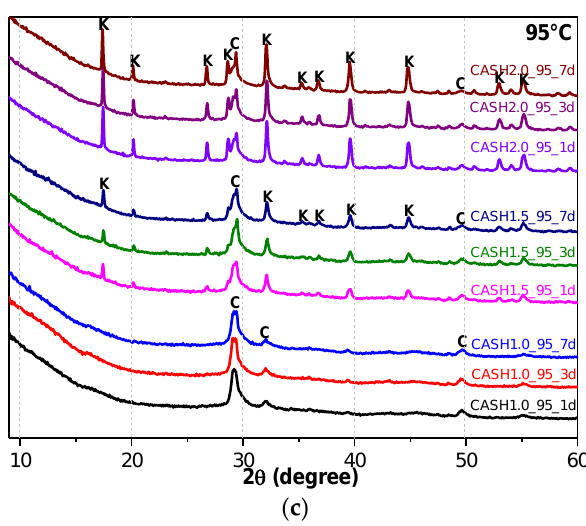
Figure 1. XRD patterns of C-A-S-H system powders; ( a ) reaction at room temperature; ( b ) reaction at 60 °C; ( c ) reaction at 95 °C. (C: C-A-S-H gels; CH: Ca(OH) 2 ; K: Katoite; CC: C 4 AcH 11 ; HE: Heulandite).